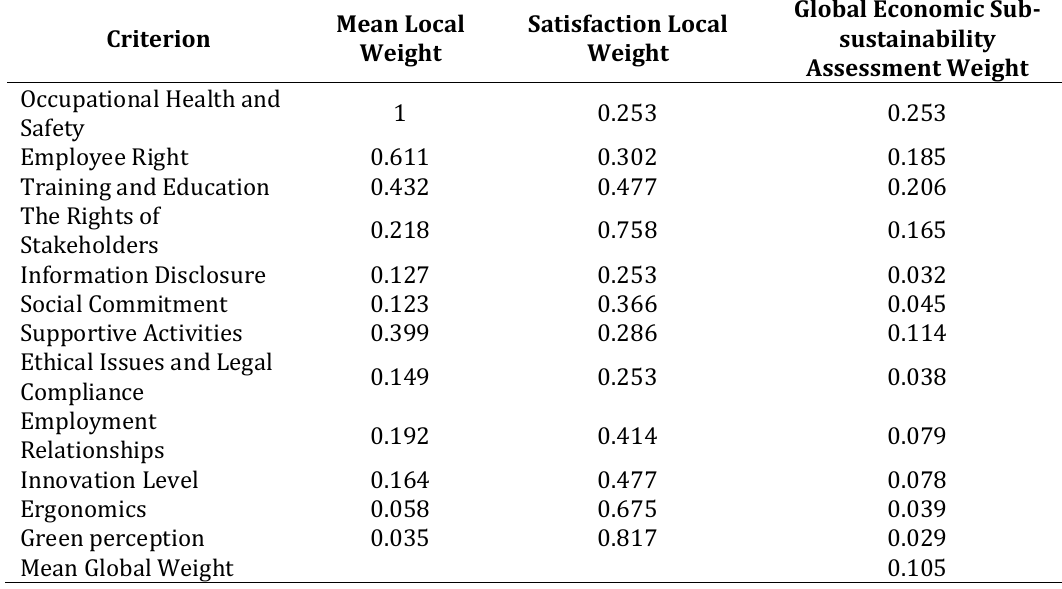
Table 5: Index weight and global weights of social sub-sustainability assessment